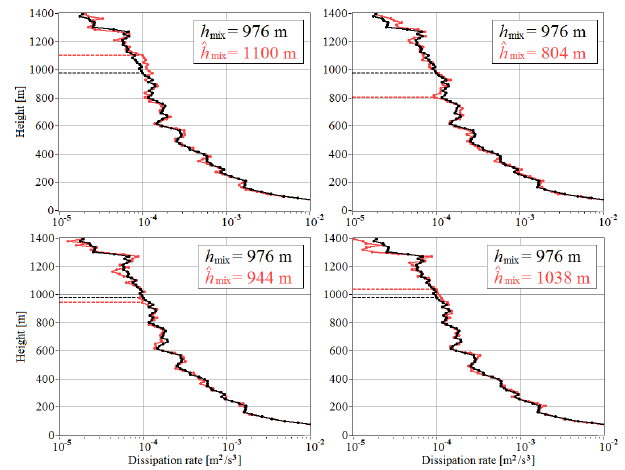
Figure 9. Measured (black curve taken from Fig. 8d) and four ex- amples of random realizations of simulated (red curves obtained with the use of Eq. 6 and data of Fig. 8c and d) vertical profiles of the turbulent energy dissipation rate.